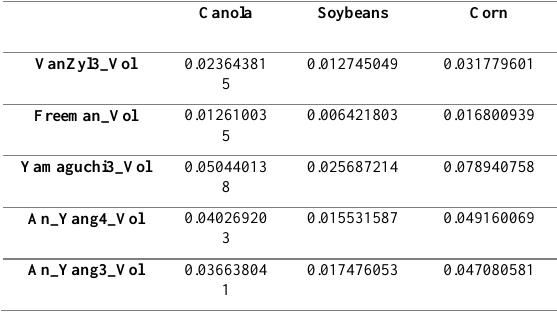
Table2 Volume scattering of each sample in 20120708 4.1 Comparison of the retrieved and measured Biomass Figure 4 indicates a comparison between the ground measurements of biomass and those retrieved using the five decomposition methods over different fields. Each point Table1 demonstrate Ground truth of each crop fields represents the matching between the field values of the retrieved 2012_07_09 and measured biomass. They confirm the higher volume scattering powers for Freeman decomposition. It can be seen Table 2 indicates the volume scattering of each decomposition from the results that the volume scattering power in method for each crop in 8 July 2012.